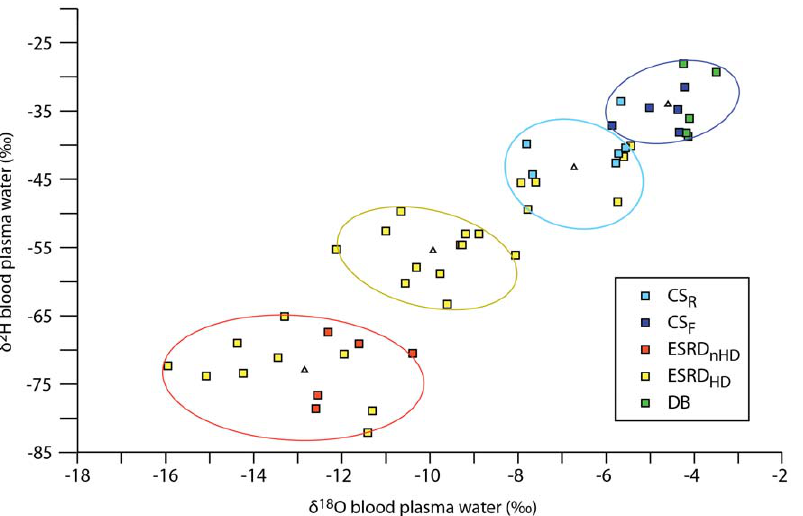
Figure 1. The stable isotopic ratios of hydrogen ( d 2 H) and oxygen ( d 18 O) in human blood plasma. Squares represent the distributions of the d 2 H and d 18 O of human blood plasma, colored by group: CS R in cyan, CS F in blue, ESRD nHD in red, ESRD HD in yellow, and DB in green. The colored circles are the clusters obtained by applying the k -means analysis with a preset of 4 clusters to the all datasets. The blue circle comprises all CS F (100%) and all DB (100%). The cyan circle is constituted of most CS R (83%) and several ESRD HD (22%). The yellow circle encloses about half of the ESRD HD data (44%). The ESRD nHD (100%) is clustered in the red circle along with 9 ESRD HD data points (33%). The triangle denotes the centroid of each cluster.